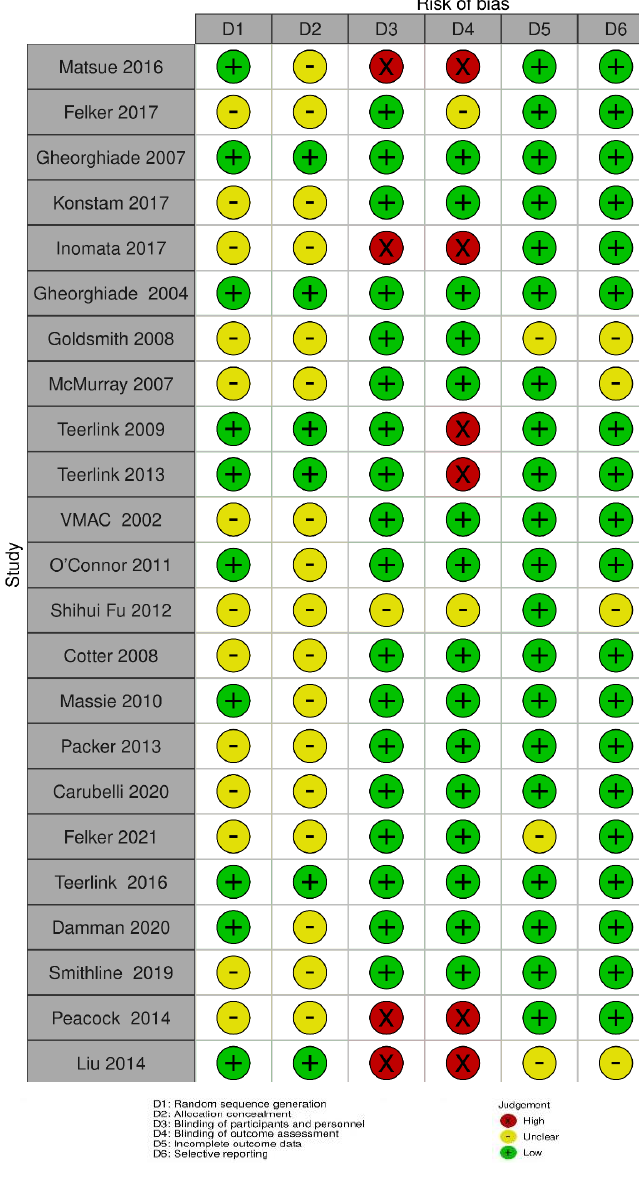
Figure 2. The quality of included RCTs: risk-of-bias per item for each study.